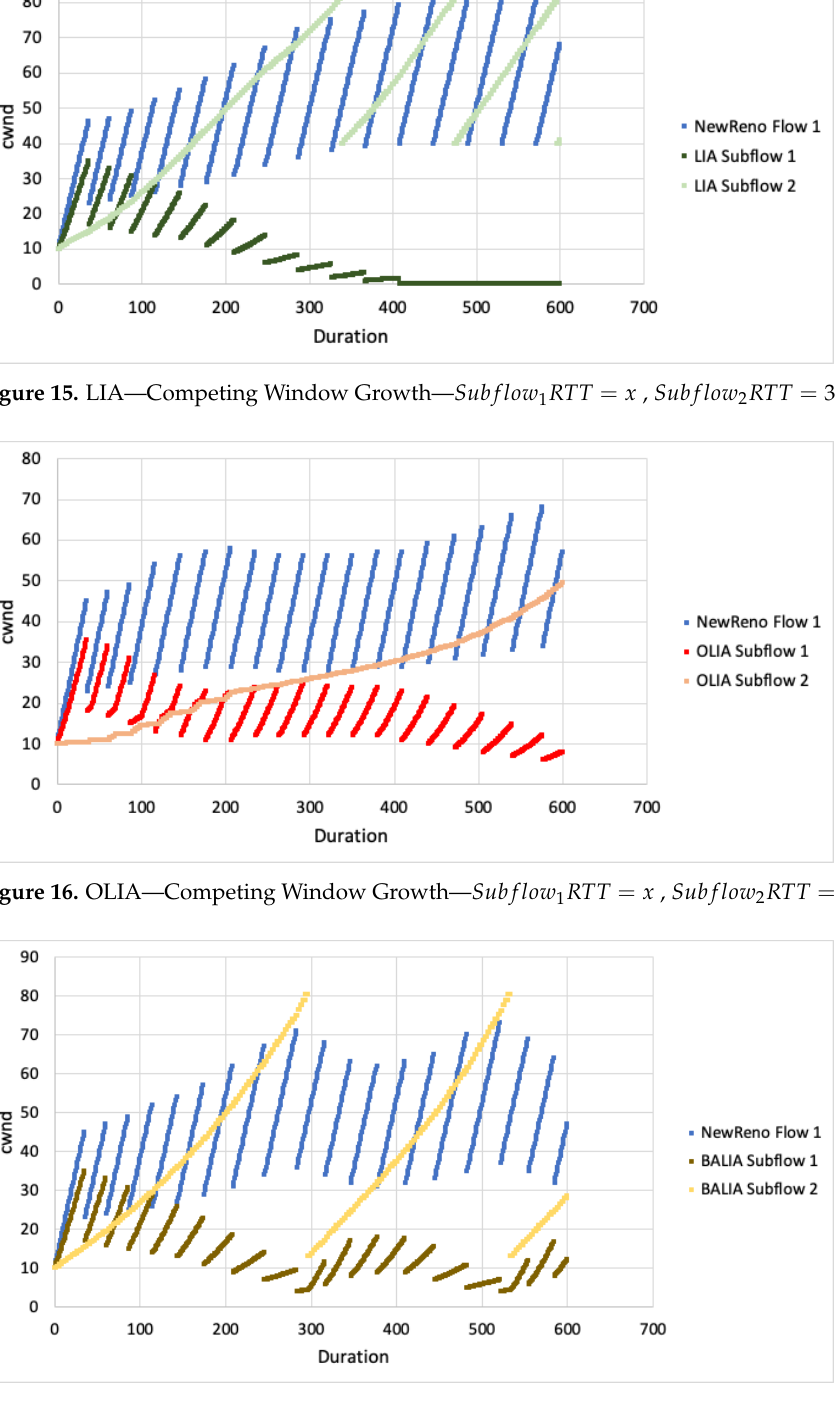
Figure 17. BALIA—Competing Window Growth— Subflow 1 RTT = x , Subflow 2 RTT = 3 x